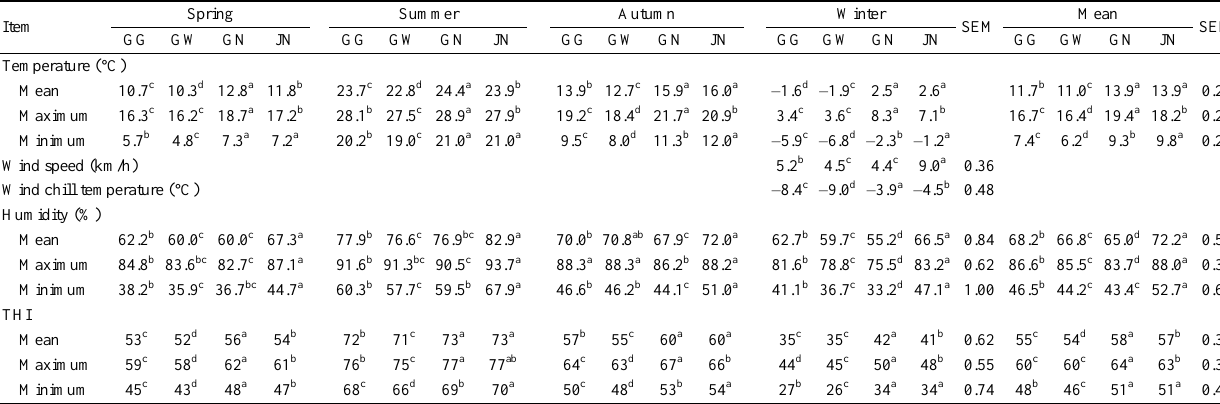
Table 3. Regional temperature data for 8 years (2006 through 2013) in South Korea Item